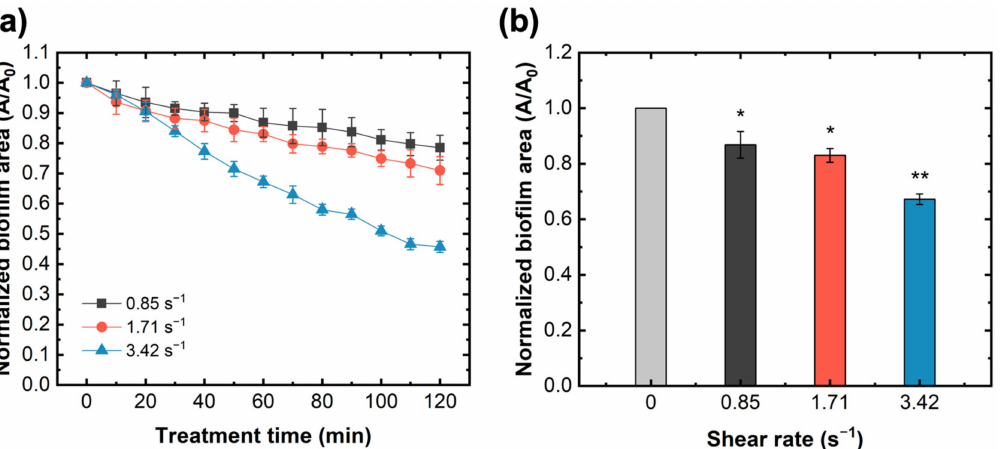
Figure 2. Normalized biofilm area formed on glass slide surface under different shear rates. ( a ) Variations of normalized biofilm area depending on different shear rates without LAE treatment and with PBS buffer for 120 min. ( b ) Reduction of biofilm under varied shear rates after a 60 min flow of PBS buffer. Error bars indicate the standard deviations of three independent measurements. * p < 0.05 versus control, ** p < 0.005 versus